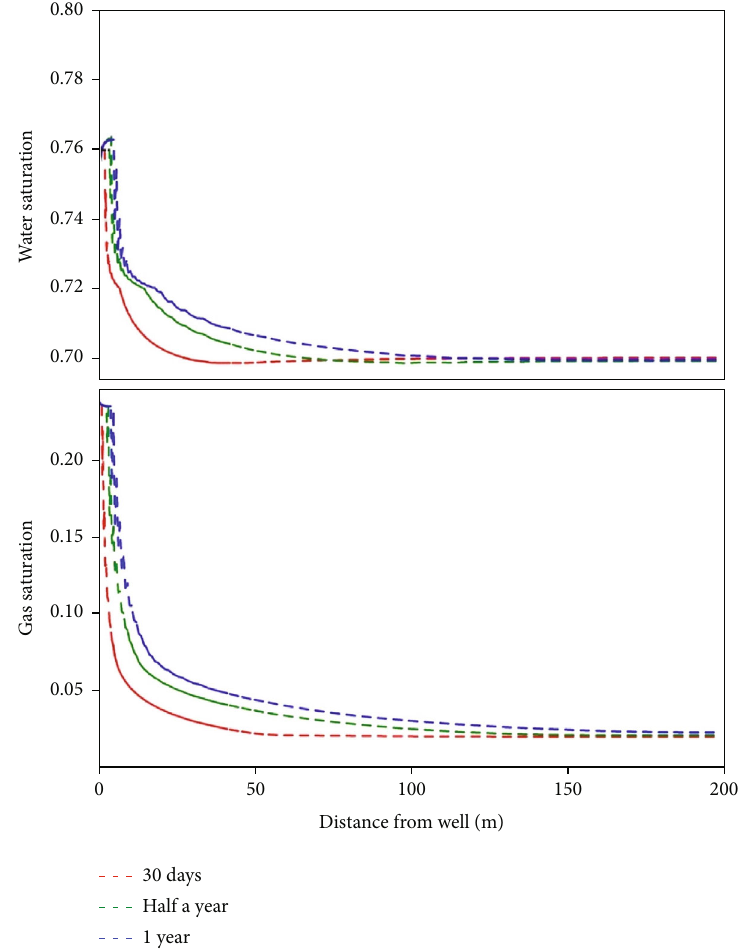
Figure 15: The distributions of water saturation and gas saturation at di ff erent times.